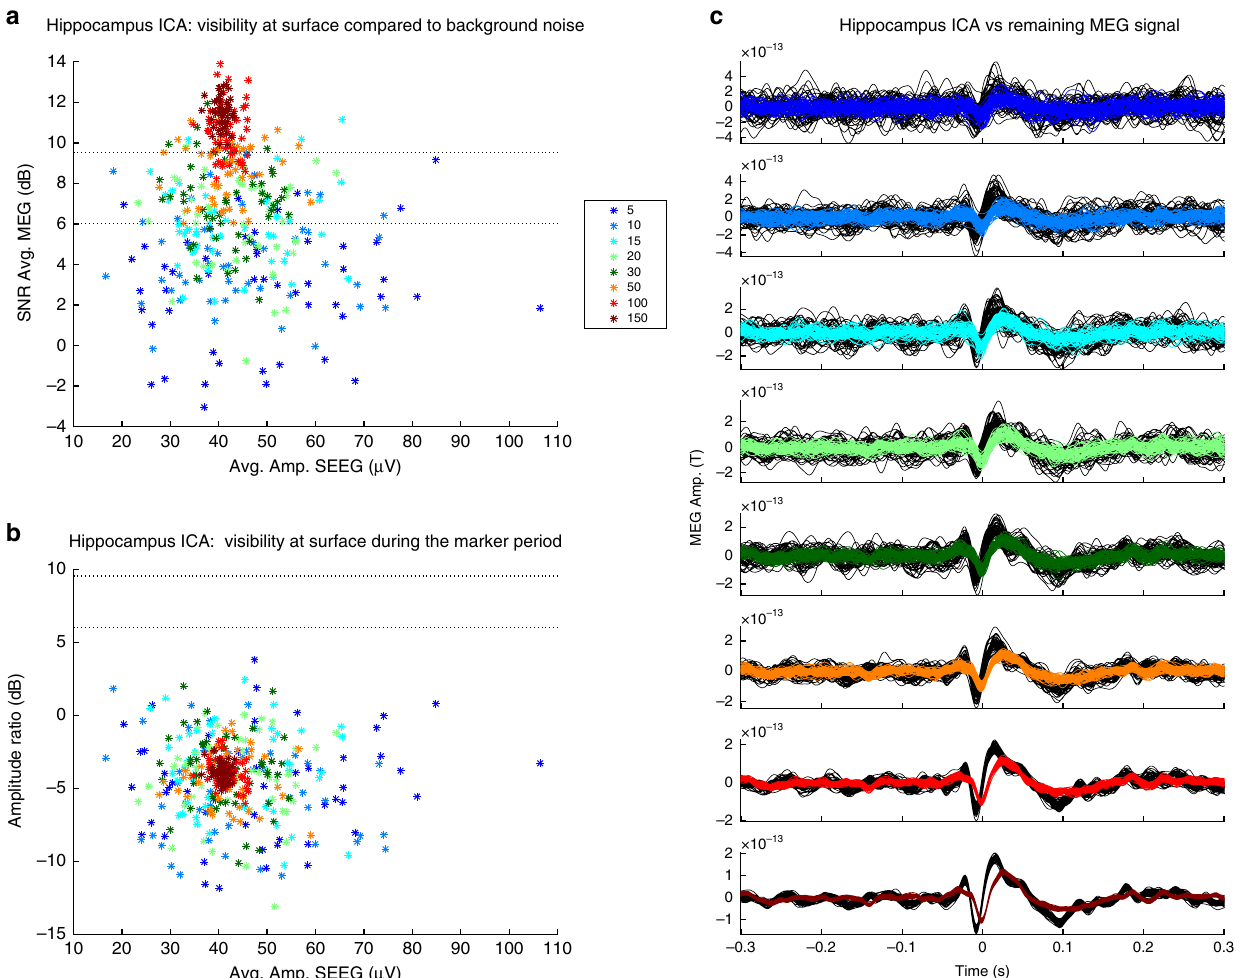
Fig. 4 SNR evaluation of a ICA component correlated with hippocampus ( “ Hippocampus ICA ” ) in the “ continuous analysis ” . a ICA visibility compared to background noise: the stars indicate the number of markers to average to obtain a certain visibility (SNR). b ICA visibility during the marked period. c Average time course of the ICA component in relationship to the MEG signal on the sensor where the ICA topography has the maximal absolute value. Each color line refers to the number of events that had been averaged (refers to fi gure